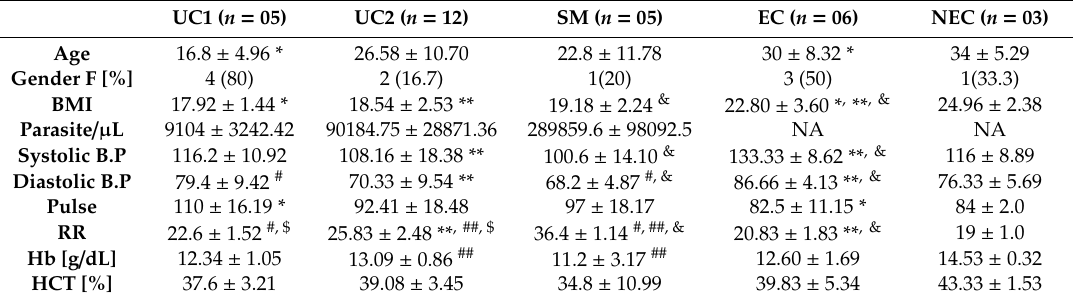
Table 1. Age, gender distribution, parasitemia level and other demographic details among di ff erent malaria clinical